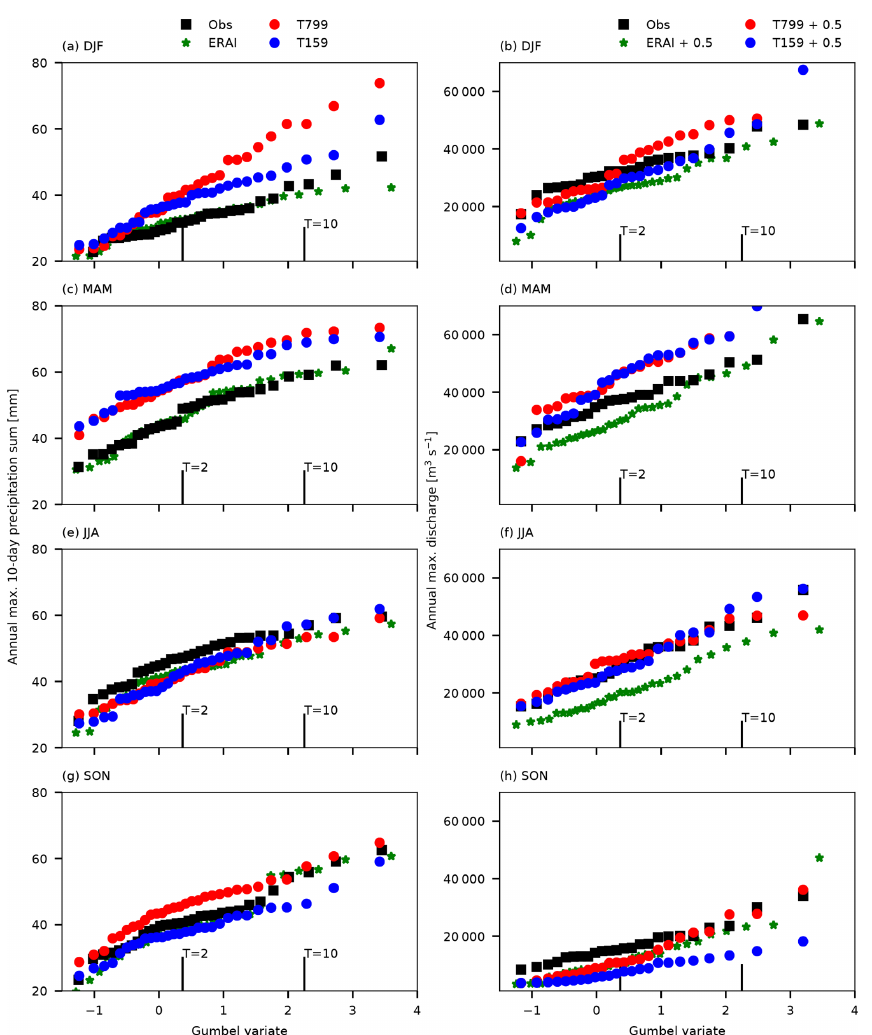
Figure 12. Gumbel plots of seasonal (DJF, MAM, JJA, and SON) maximum 10-day precipitation sums (mm) over the Mississippi (a, c, e, g) and maximum discharge (m 3 s − 1 ) at Vicksburg (b, d, f, h) and their related return times T expressed in standardized Gumbel variate x = − ln ( − ln (T )) . Observed discharges are shown in black, high-resolution forcing (T799) in red, low-resolution forcing (T159) in blue, and forcing with ERA-Interim in green. The discharge results are output from the 0.5 ◦